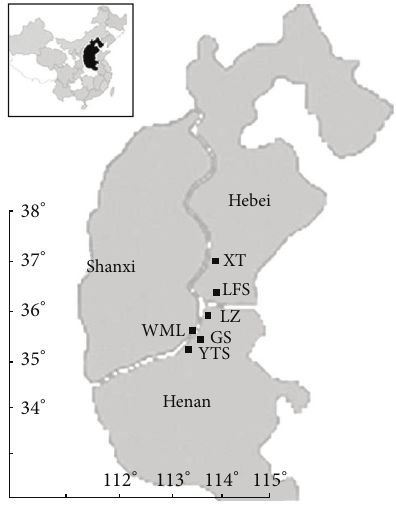
Figure1:Geographicdistributionandsamplingsitesin Opisthopap-